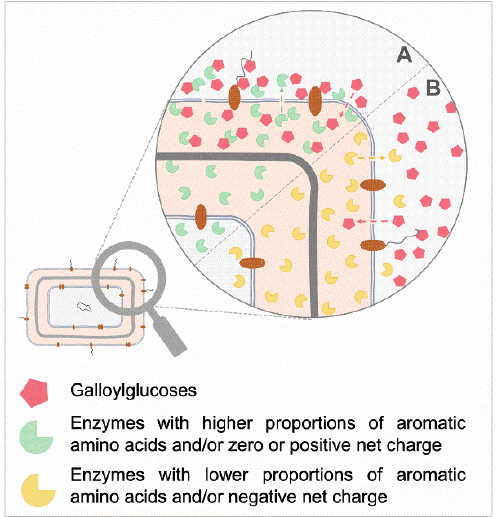
Figure 6. Hypothesized roles of the nature of expressed resistance enzymes in mediating the inter- actions between bacterial cells and galloylglucoses. The resulting differences in the galloylglucose concentration around the bacterial cells might contribute to the observed differences in susceptibil- ities.